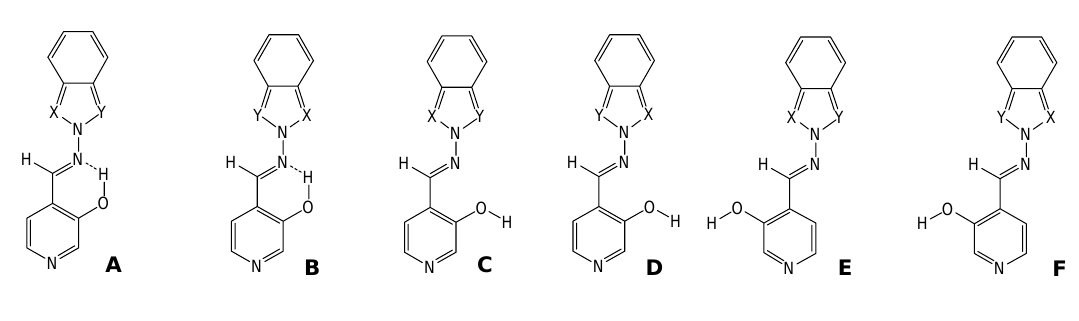
Figure 2. Calculated conformations A - F for ( E )-4-[(2 H -benzazol-2-ylimino)methyl]- pyridine-3-ols ( 7c , X=N, Y=CH; 7e , X=Y=N).